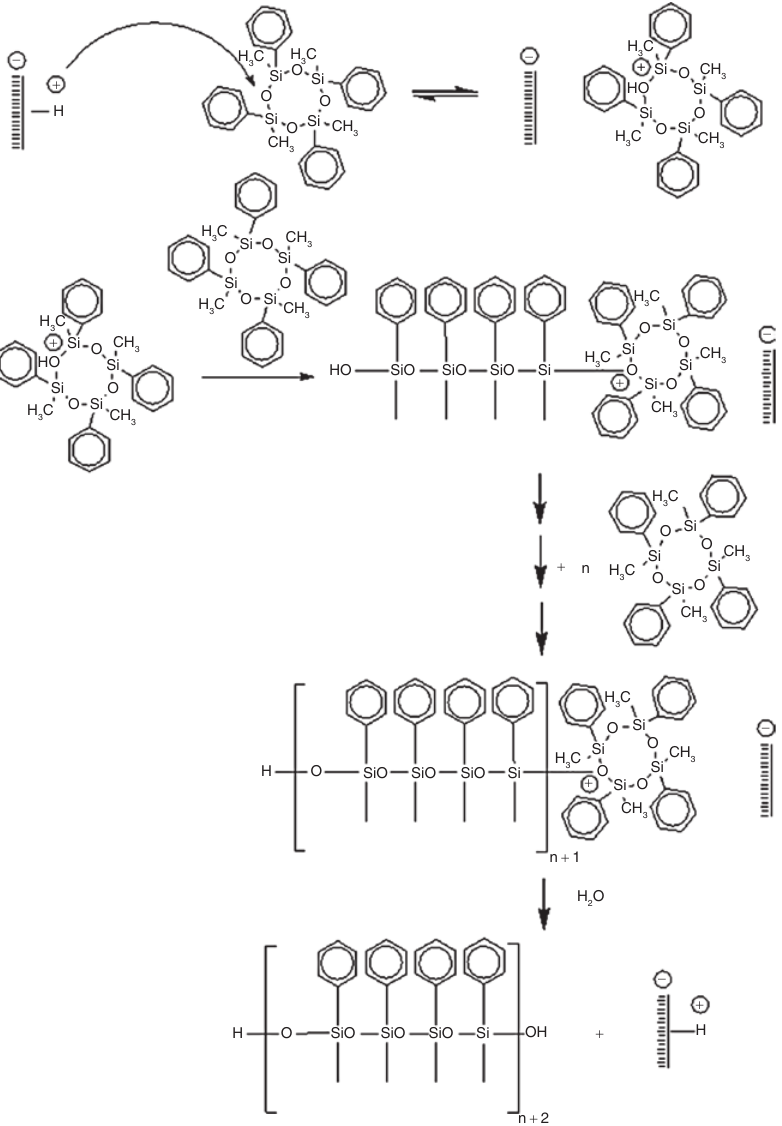
Scheme 3: Mechanism of tetraphenyltetramethylcyclotetrasiloxane (D 4Ph,Me ) polymerization catalyzed by Maghnite-H +